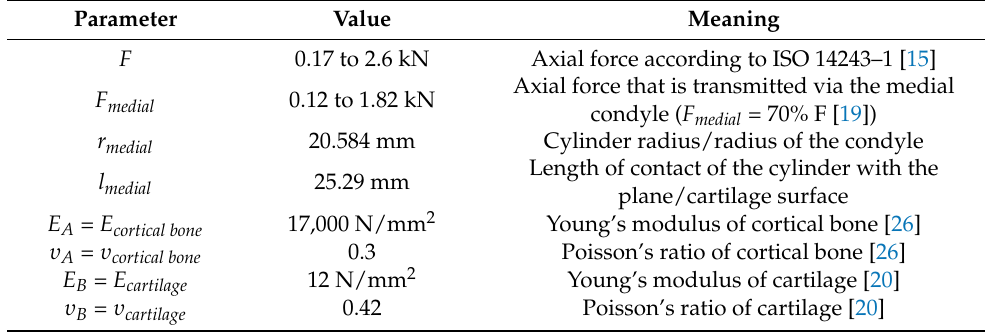
Figure 4. Algorithmic estimation of condyle radius and width. ( a ) Contact points of simulated flexion movement on the distal femur; ( b ) optimal cylinder fitted to the contact points; and ( c ) curve along and through the medial condyle approximating the describing contact for a flexion angle of 15.32°. The parameters used are summarized in Table 1. Table 1. Parameters used to determine the physiological contact pressure in the medial knee joint.